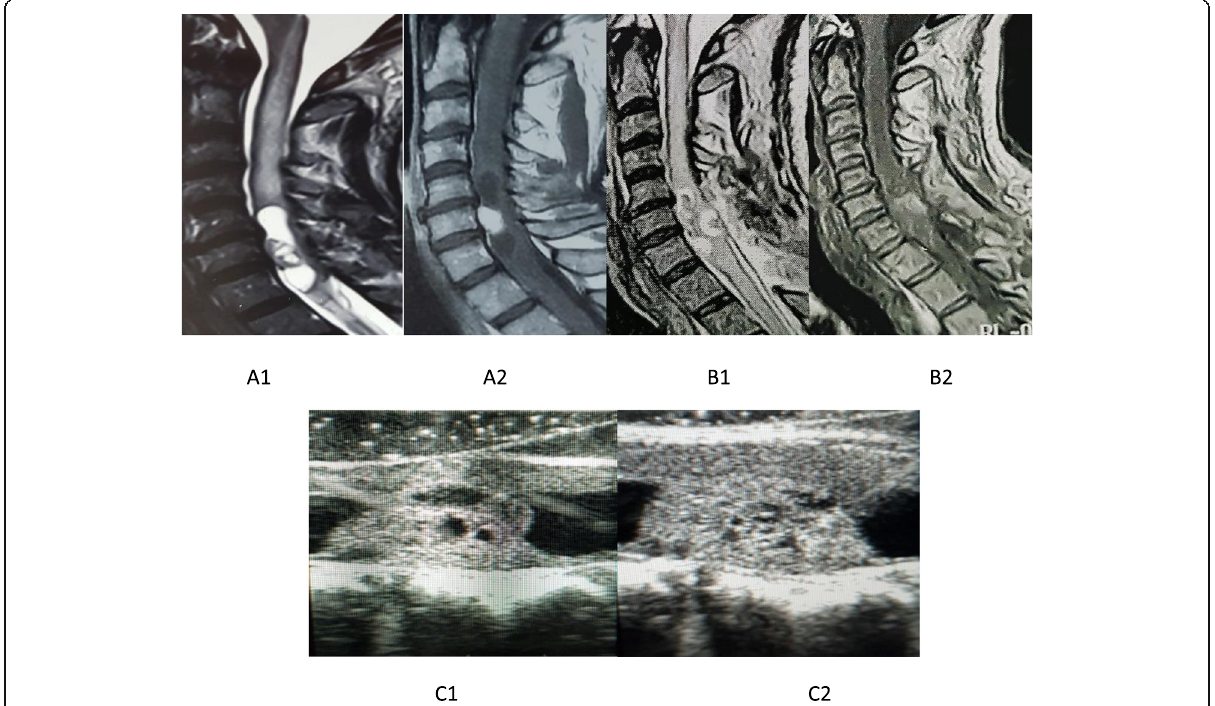
Fig. 4 Case of spinal metastatic ependymoma. A1 , A2 Preoperative MRI T2 and T1 cervical spine with intramedullary metastatic ependymoma. B1 , B2 Postoperative MRI T2 and T1. C1 , C2 Intraoperative ultrasound images showing hypoechoic cystic parts and hyperechoic fleshy tumor